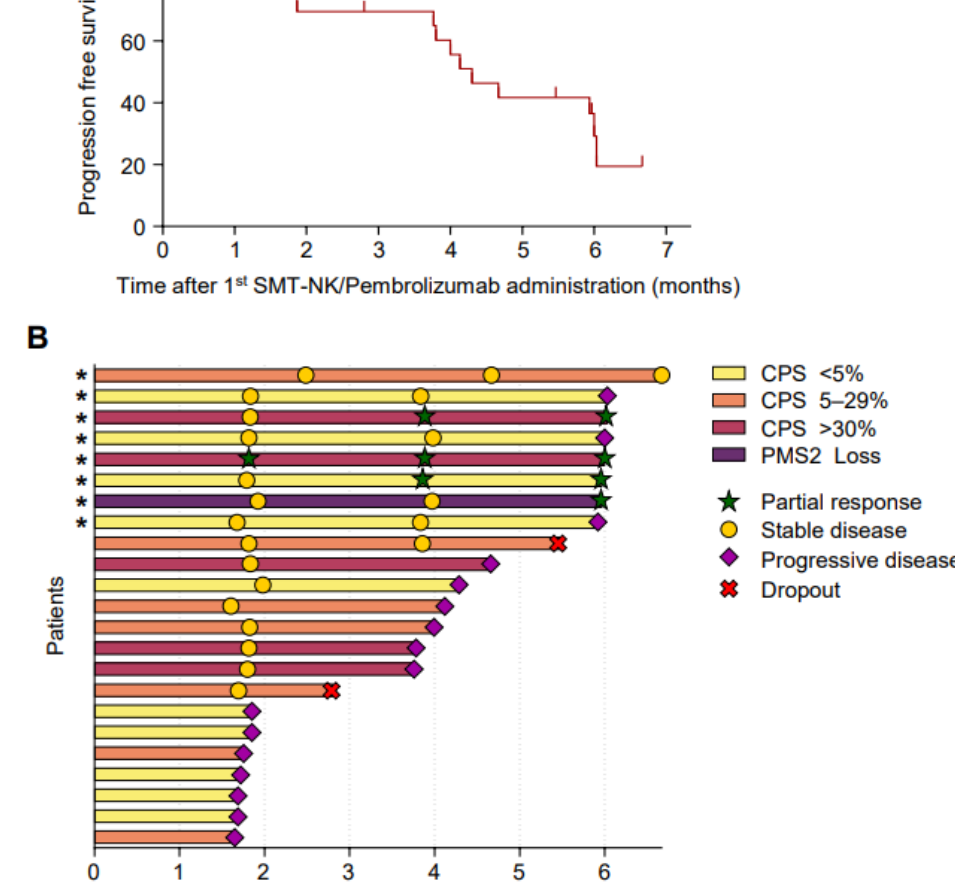
Figure 4. Progression-free survival and time to progression for each patient. ( A ) Kaplan–Meier estimates of the progression-free survival in the full analysis set. ( B ) Time to progression. The yellow bars indicate patients with a combined positive score (CPS) < 5%, orange bars CPS 5–29%, and red bars CPS > 30%. The purple bar indicates a patient who lost PMS2 . * The patient completed 27 cycles of treatment.